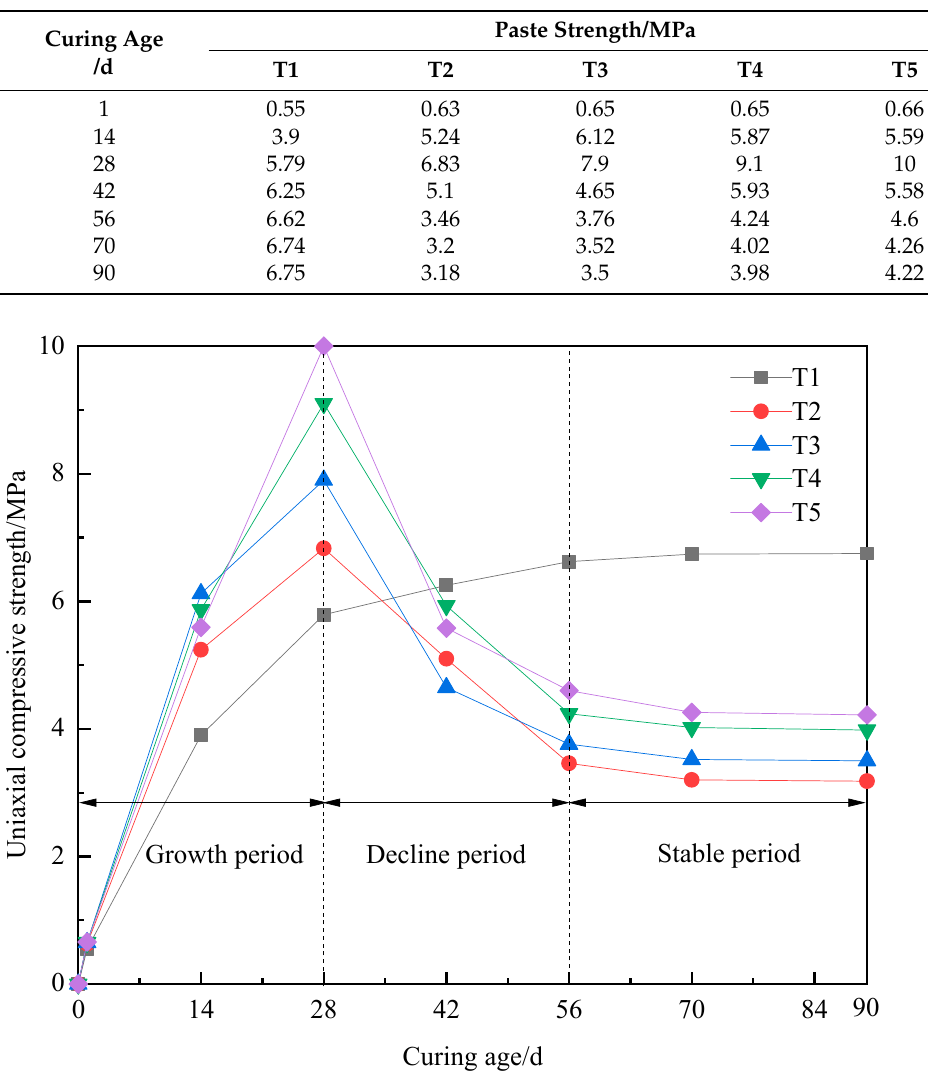
Figure 3. Diagram of compressive strength relationship of different samples with curing age.